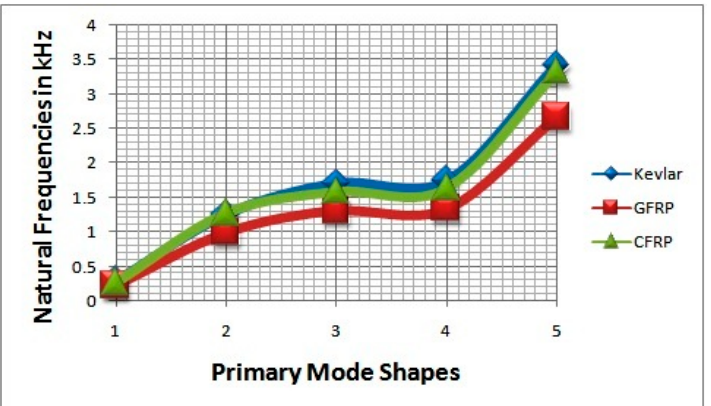
Figure 25. Comprehensive details of linear mode shapes versus natural frequencies for different composites—UAV Wing.